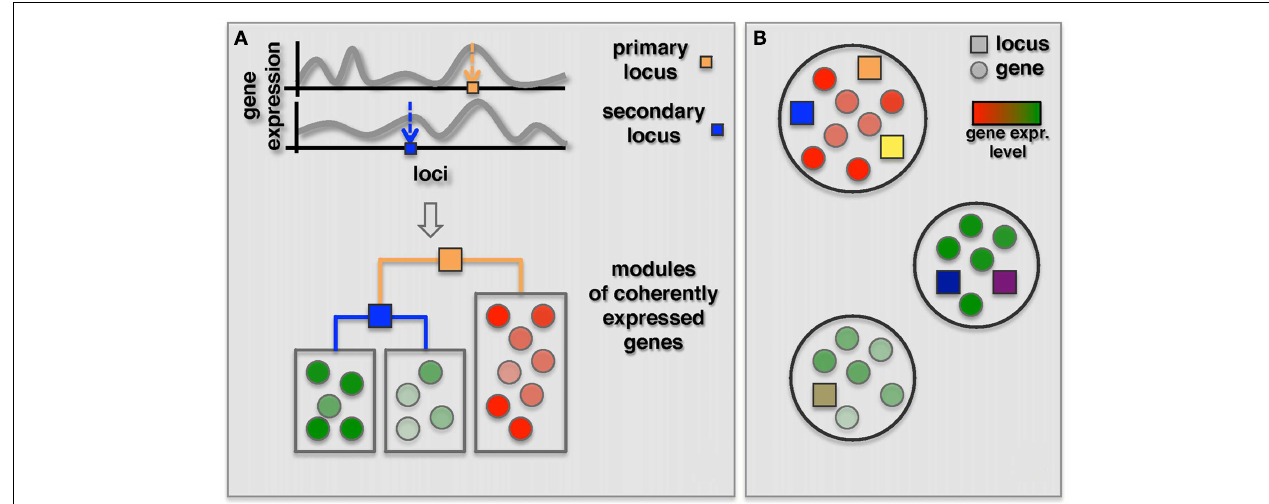
additional genes consistent with the decision tree model are included. (B) Bayesian partition method simultaneously identifies co-expressed modules and their regulating loci using a MCMC approach. Genes in each module are represented by circles colored according to their gene expression and loci are represented by squares where different colors represent different